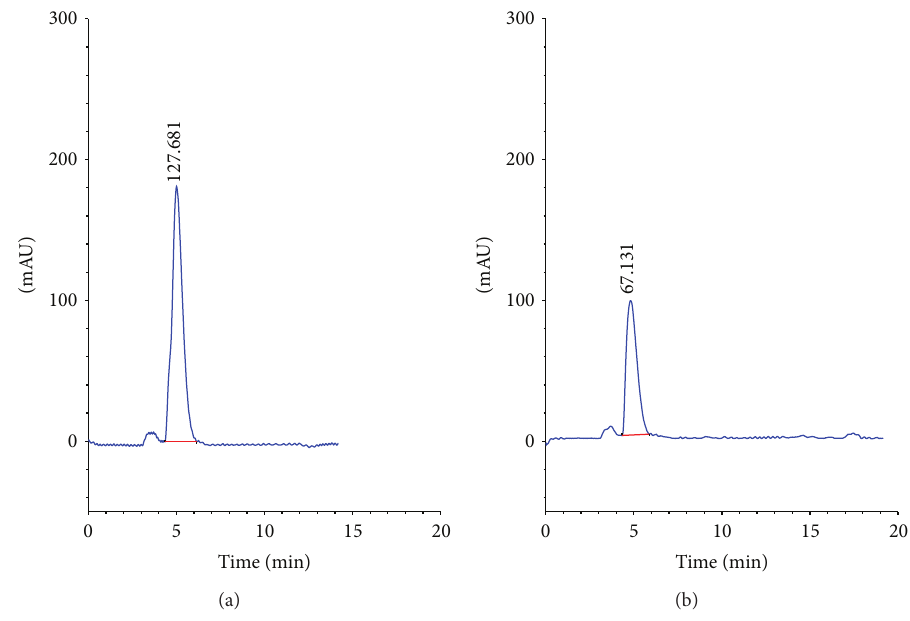
Figure 2: DPPH chromatogram of (a) blank and (b)